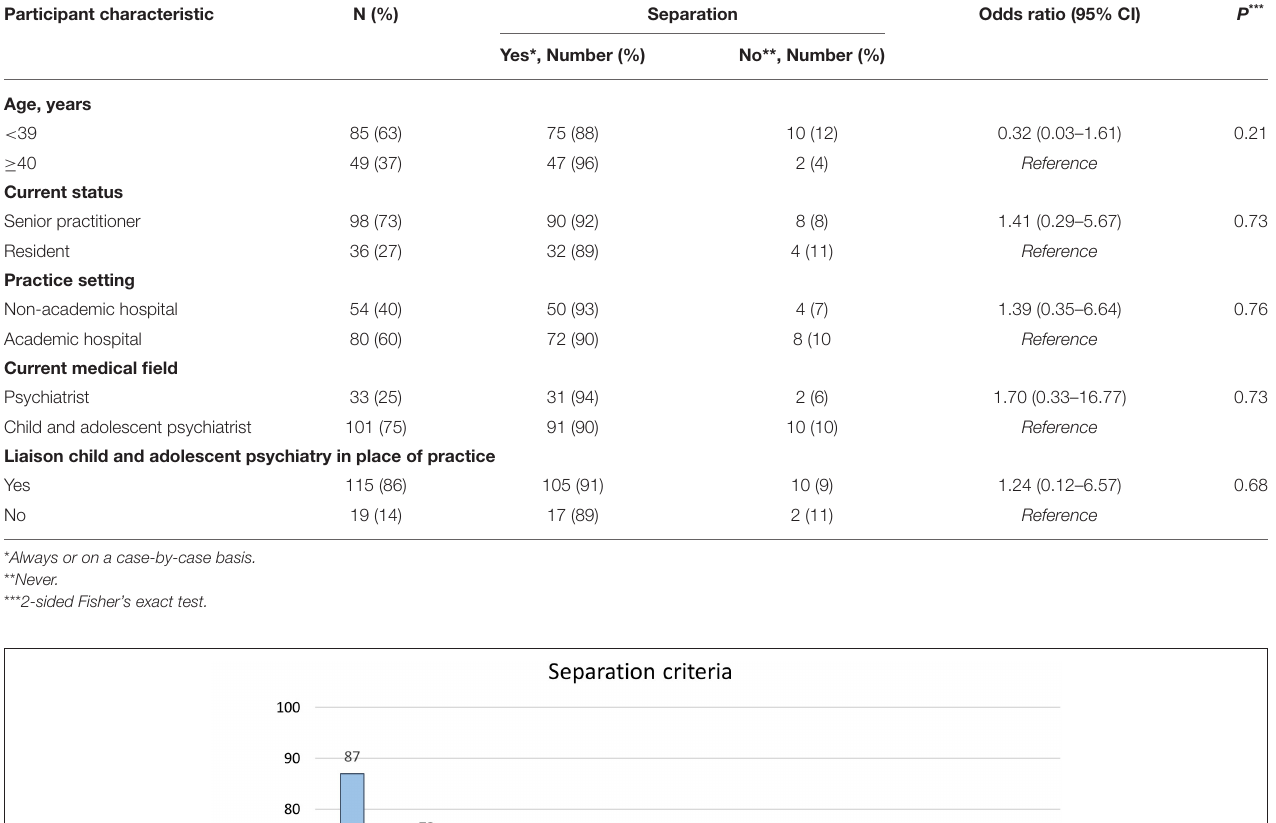
TABLE 2 | Association between participant characteristics and the practice of separation ( N = 134). Participant characteristic